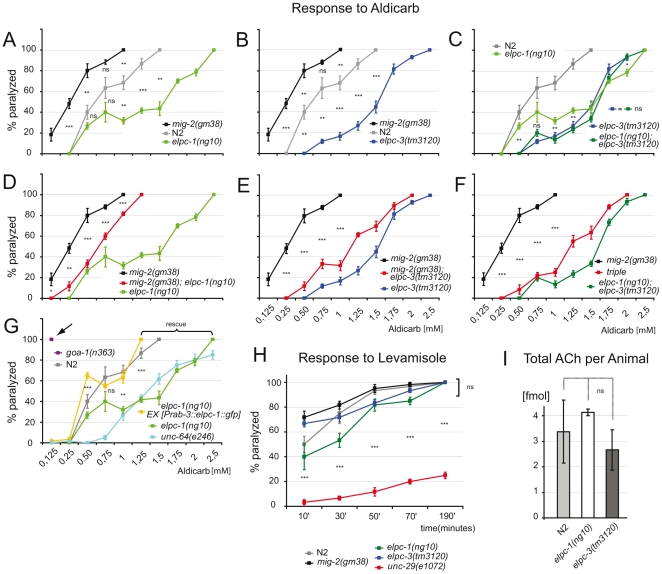
Response to aldicarb and levamisole.(A) Percentage of paralyzed adult animals in response to aldicarb. Each point of the curve represents the average of 5 experiments. mig-2(gm8) are more sensitive than wt(N2) and elpc-1(ng10) is resistant. p value is calculated for each drug concentration. (B) elpc-3(tm3120) are aldicarb resistant. (C) elongator double mutants are not significantly different from single mutants. (D) elpc-1(ng10) suppresses mig-2(gm38). (E) elpc-3(tm3120) suppresses mig-2(gm38). (F) elpc-1(ng10); elpc-3(tm3120) suppresses mig-2(gm38) in a triple mutant. (G) Neuronal expression of elpc-1 rescues the aldicarb resistance of elpc-1(ng10). The resistance to aldicarb of elpc-1(ng10) under these conditions is similar to syntaxin mutants (unc-64(e246)
[44]). Classical mutants that are hypersensitive to aldicarb are severely more sensitive than mig-2(gm38). Arrow points to the already fully paralyzed phenotype at low concentration of the hic mutant goa-1(n363)
[45]. (H) Response to 100 µm levamisole to test the postsynaptic apparatus. All genotypes tested are similar to wt(N2). (I) Amount of acetylcholine per adult animal determined by chromatography. P values: ns = not significant; *<0,05; **<0,01; ***<0,001. Error bars: SEM.